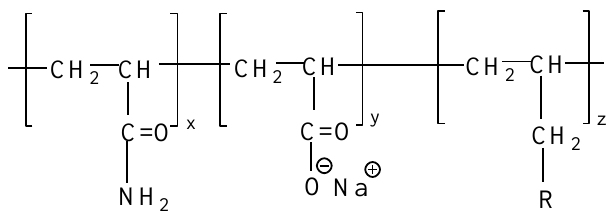
Figure 2. The molecular formula of AP-P4.